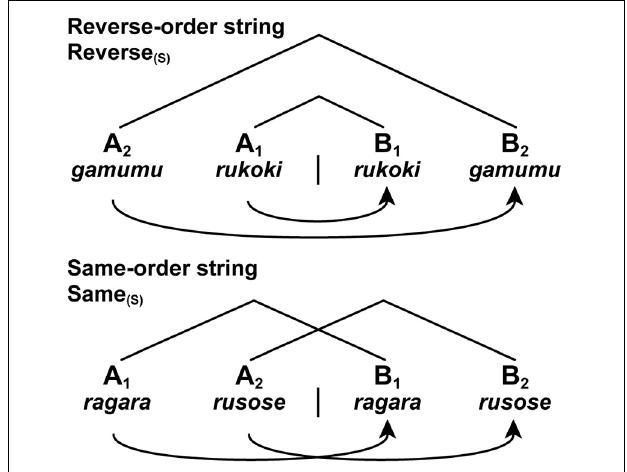
FIGURE 2 | Two basic types of letter strings related to formal languages. We tested two string conditions with short [(S) as a subscript] stimuli: Reverse ( S ) and Same ( S ) . Each letter string was formed by jumbling letters of either a pseudonoun or pseudoverb (see Figure 4 ). We also tested the long stimuli with six items. Each curved arrow with an arrowhead denotes a Search operation, as in the following figures. Symbols used: A, sample stimulus; B, comparison